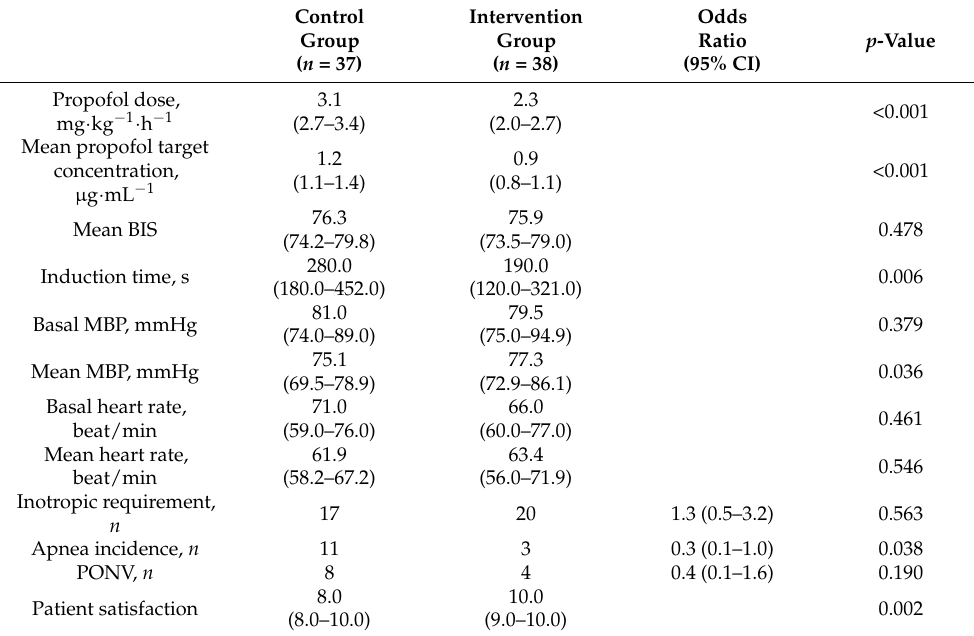
Table 3. Anesthesia and complication